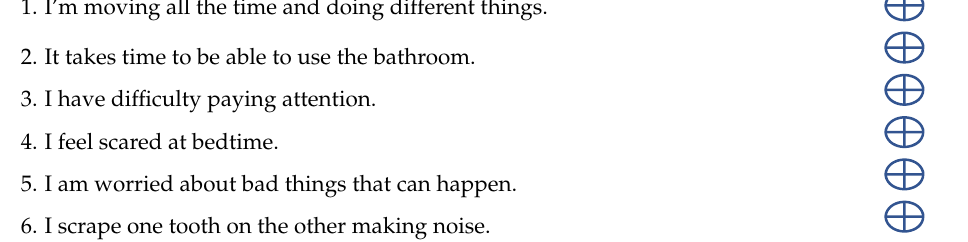
Table A2. Data collection instrument for the Infantile Stress